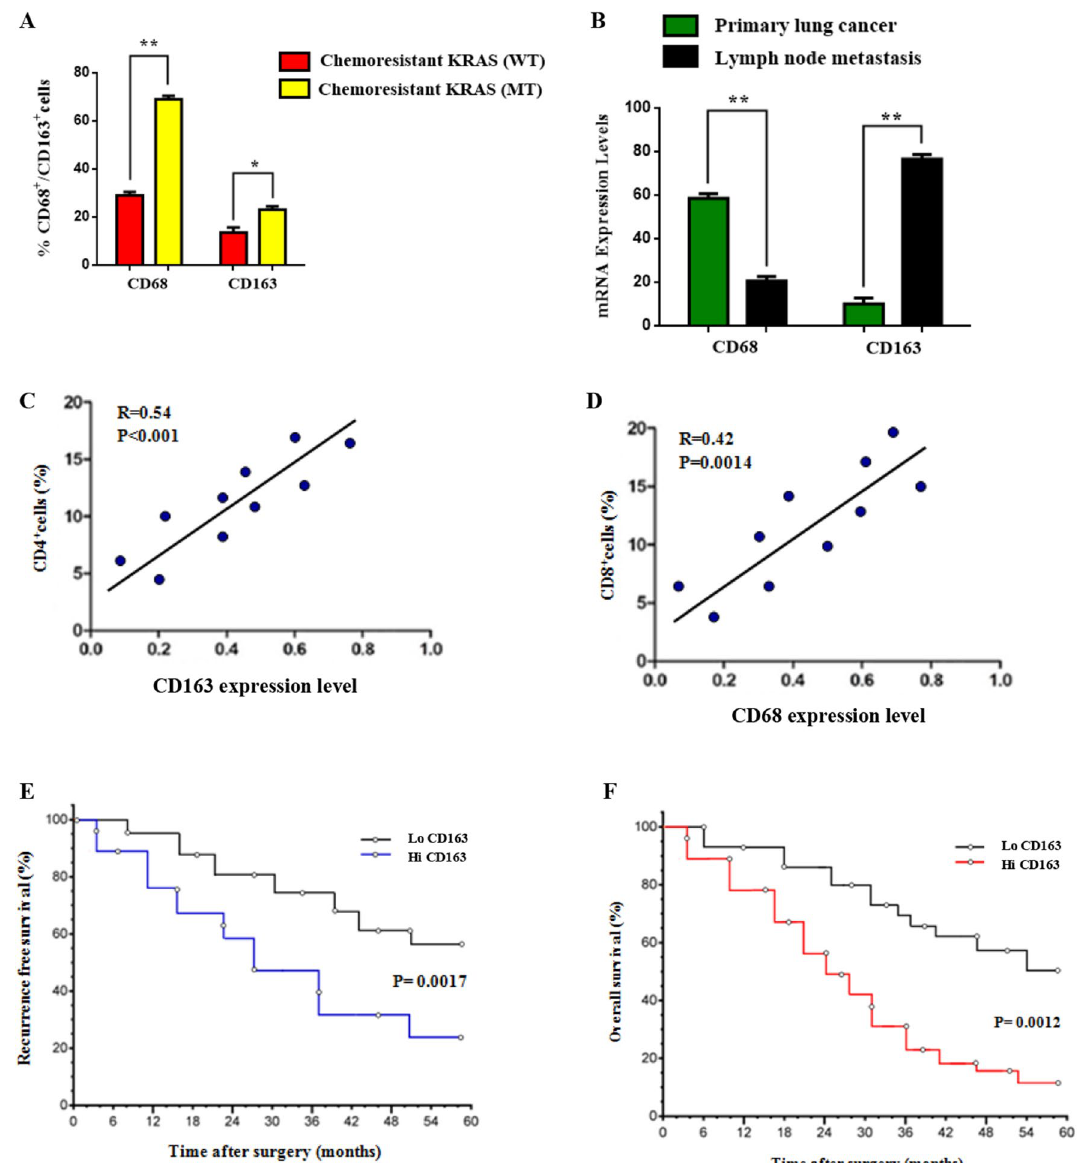
Figure 1. Polarization of CD163 + M2 macrophages correlates with mutant Kras status. ( A ) Association of M2 macrophage (CD68 + /CD163 + ) levels with Kras (WT/MT) chemoresistant patients, using FACS analysis. ( B ) Comparative CD68 + /CD163 + mRNA expression in primary lung cancer or LN metastatic tissues. ( C , D ) Association between the CD4/CD8 ratio and M2 macrophage markers CD68 + /CD163 + . The degree of positive correlation was higher in CD4 subset in comparison with CD8 group (R = 0.54 vs. R = 0.42). ( E , F ) Percentage of recurrence-free survival (RFS) and overall survival (OS) in LC patients with high or low CD163 + expression. The results represent the mean ± SD of three independent experiments. Statistically significant data are indicated by asterisks (*p < 0.05, **p <